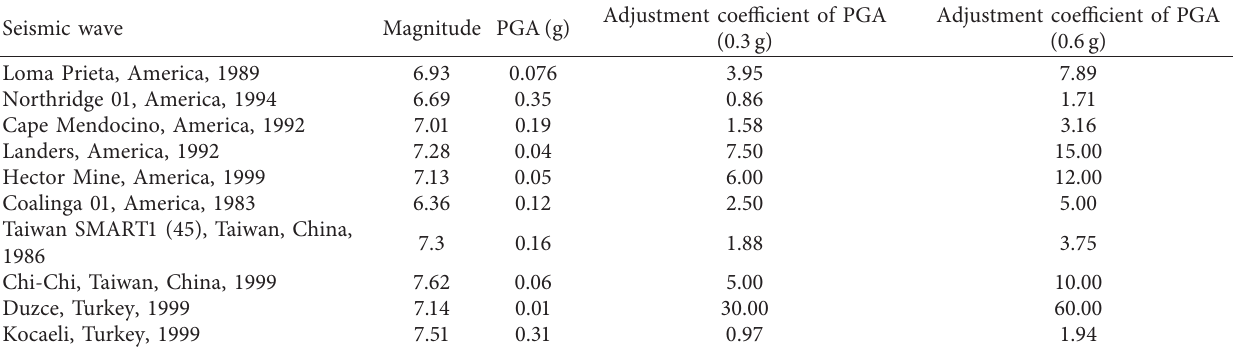
(c)Cover Figure 1: The bridge details: (a) bridge schematic; (b) the simplified model of bridge pier; (c) pier cross section. Table 1: Horizontal and vertical time-history analysis of seismic wave